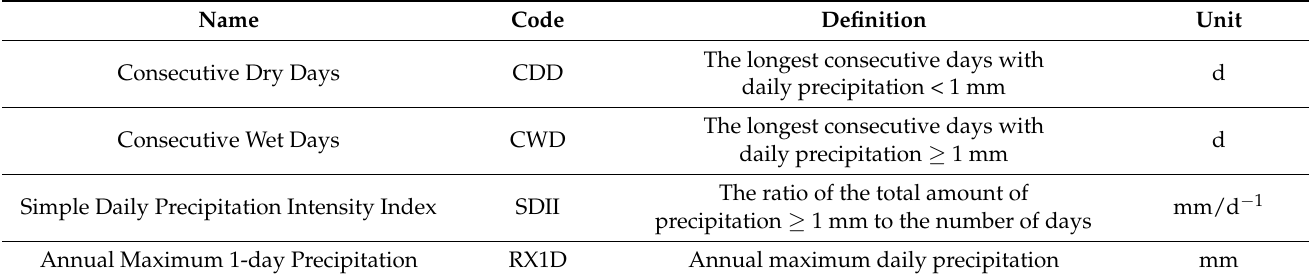
Table A2. Name and meaning of extreme climate